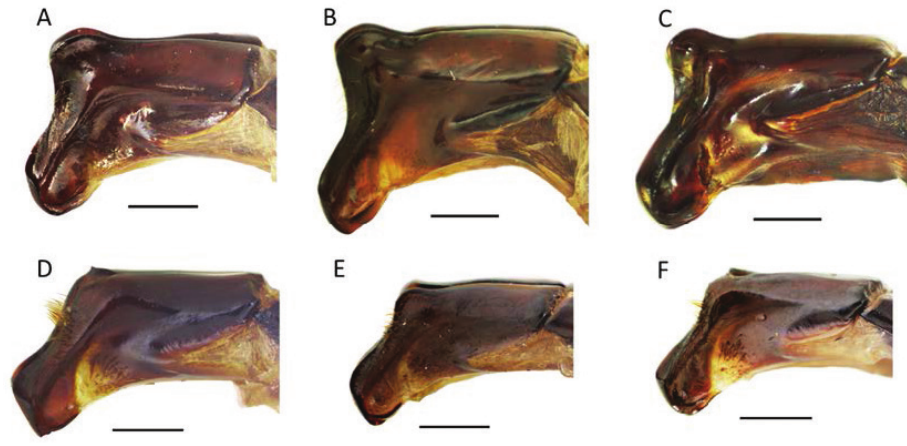
Figure 4. Lateral side of parameres, in O. eremita ( A–C ) and O. cristinae ( D–F ), showing intraspecific variation and difference on the parameres between the two species (photo by Federico